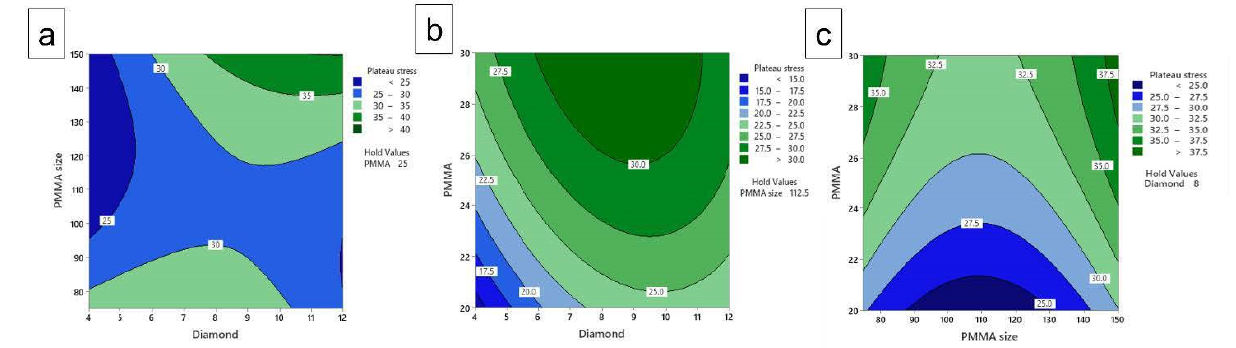
Figure 13. Contour plot of plateau stress for, ( a ) PMMA size vs. diamond content ( b ) PMMA vs. diamond content and ( c ) PMMA size vs. PMMA content.